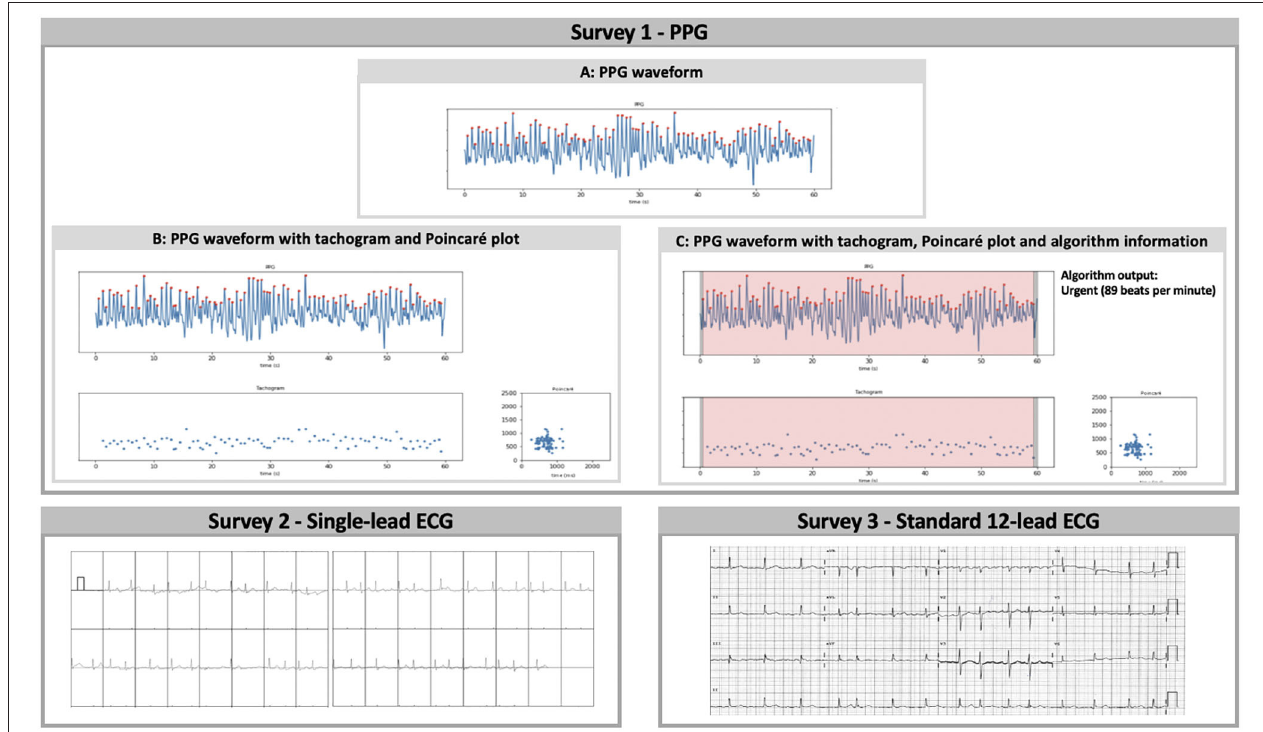
FIGURE 1 | Survey 1: (A) PPG waveform, (B) PPG waveform with tachogram and Poincaré plot, and (C) PPG waveform with tachogram, Poincaré plot, and algorithm information were separately and consecutively shown for qualitative analysis in the first survey. The tachogram shows the duration of each peak-to-peak interval in milliseconds, while the Poincaré plot visualises the randomness of the heart rhythm by plotting each interval on the x -axis (ms) vs. the preceding interval on the y -axis (ms). The proprietary algorithm classified measurements with sufficient signal quality as normal (regular rhythm, green), warning (possible non-AF irregularity, orange), or urgent (possible AF, red). Survey 2: The performance of single-lead ECG analysis was assessed via the second survey. The vertical dashes underneath the QRS-complexes represent potential heartbeats detected by the Kardiamobile ® algorithm. Survey 3: Finally, subjects were invited to qualitatively analyse traditional 12-lead ECG recordings in the third survey. PPG, photoplethysmography; ECG,